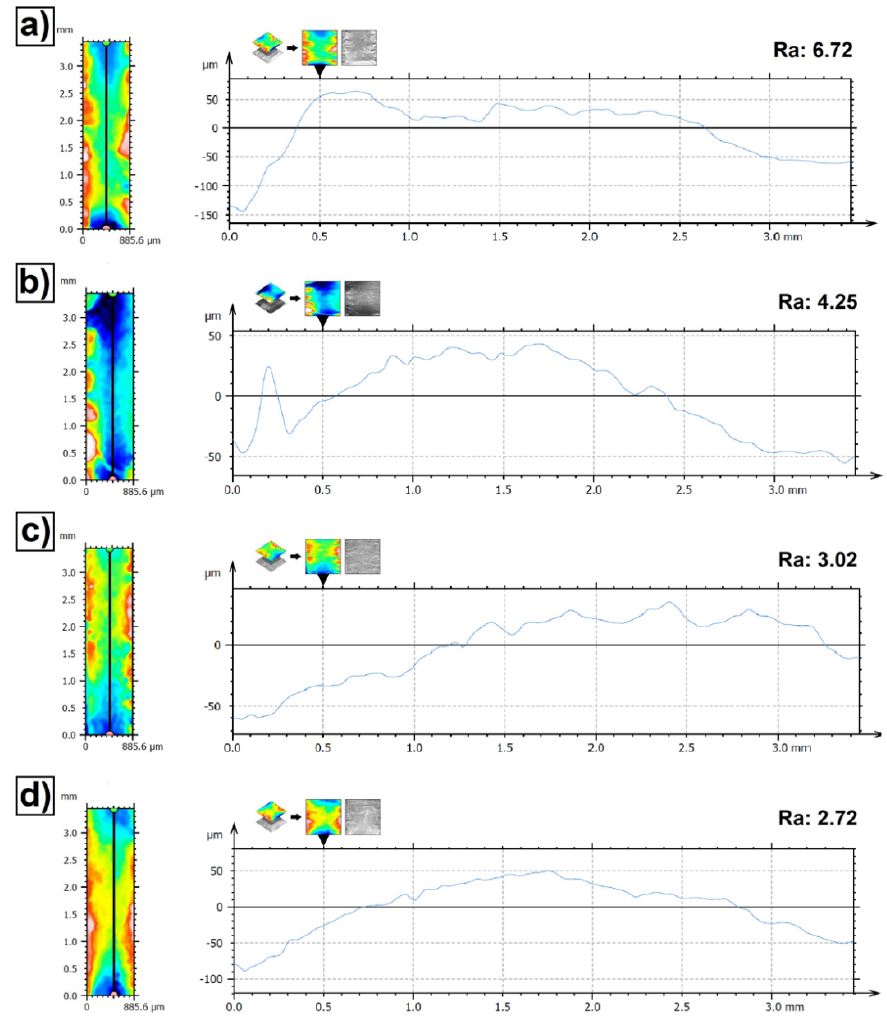
Figure 4. Surface roughness of Fe/ZrC coatings—single laser tracks produced using laser beam power of 500 W ( a ), 700 W ( b ), 900 W ( c ) and 1100 W ( d ) . With increasing power, the remelted zone increased in thickness from about 190 µm at 500 W, to about 250 µm (700 W) and 280 µm (900 W) up to about 410 µm for a coating produced at 1100 W. The thickness of the heat-affected zone increased much less as the values were: 150 µm, 160 µm, 185 µm and 204 µm respectively. In the upper part of some coatings, characteristic burrs are visible which were formed by fusing the pre-coating and the lack of remelting of this coating with the substrate on the sides of the track. This prob- lem should be eliminated by making multiple tracks. As seen in Figure 5, the part of the precoating that was not remelted fell off in sample preparation (during cutting). This was due to a rather poor adhesion of the precoating to the steel substrate. However, the pre- coating adhesion is good enough and it is expected that when making multiple tracks it will continue to function as a surface modifier and will not fall off in laser processing, which had been repeatedly observed by the author in earlier studies. A composite struc- ture was observed in all the analyzed coatings as agglomerates of ZrC particles in an iron- based matrix were obtained. They are visible as white spots against a dark background. These agglomerates were characterized by a very diverse structure and size. Some of them were compact with a structure similar to the sintered material. Elsewhere, the agglomer- ates were less compact and resembled a coating produced by laser cladding with powder. The idea behind producing Fe/ZrC coatings was to obtain coatings with a most homoge- neous structure and of a composite nature. The high-melting ZrC powder particles (3540